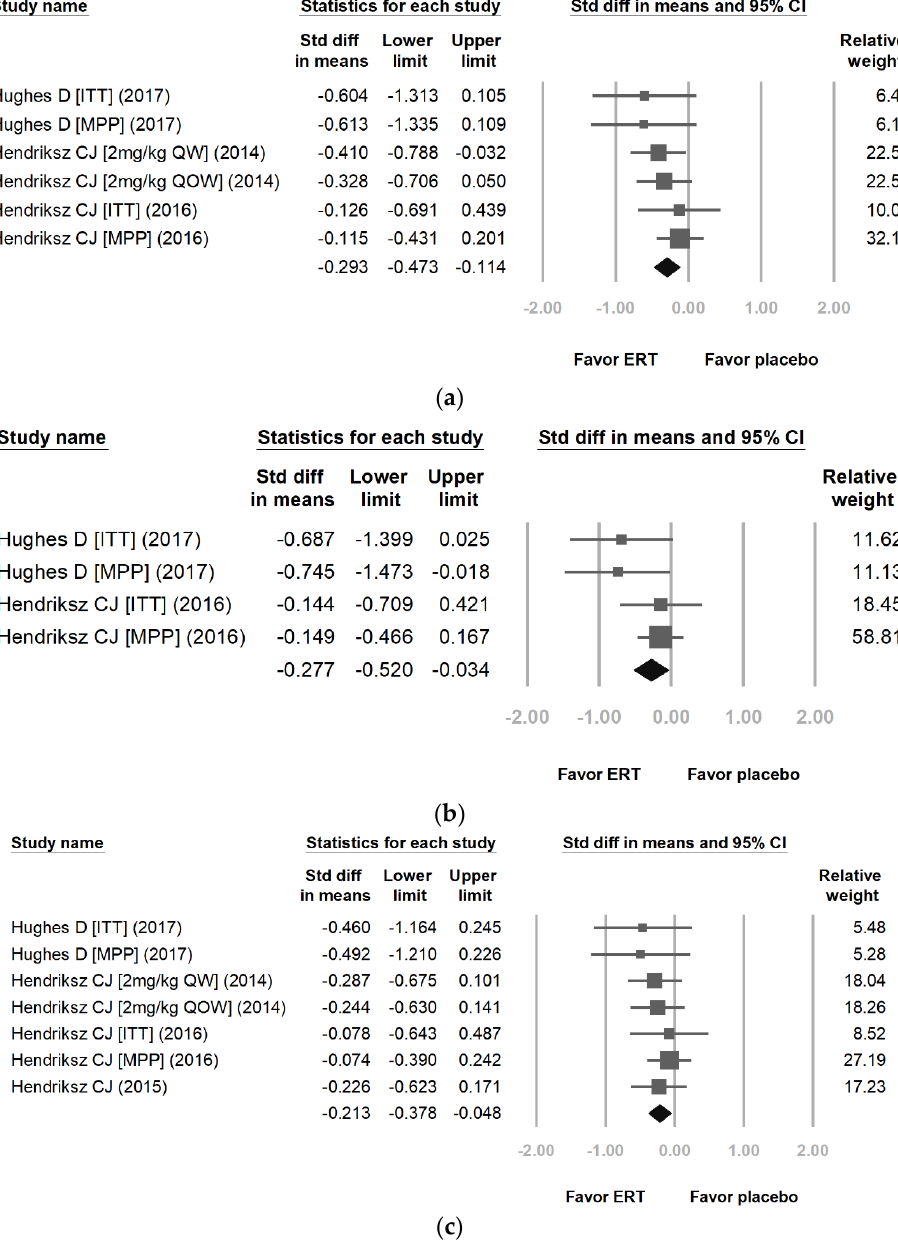
Figure 5. Proportional meta-analysis result for a pooled proportion from two cohort studies and one randomized controlled trial (RCT) for forced vital capacity (FVC), the first second of forced expiration (FEV1), and maximal voluntary ventilation (MVV) in MPS IVA. The pooled proportions analysis showed that the difference in means of ( a ) FVC [22,24,26], ( b ) FEV1 [22,24], and ( c ) MVV [22,24,26,27] between the enzyme replacement therapy (ERT) group and the placebo treatment group were ( a ) − 0.293 [95% CI: − 0.473, − 0.114; heterogeneity: I 2 = 0.00%, p = 0.631; overall effect: p = 0.001], ( b ) − 0.311 [95% CI: − 0.601, − 0.020; heterogeneity: I 2 = 18.90%, p = 0.296; overall effect: p = 0.025], and ( c ) − 0.213 [95% CI: − 0.378, − 0.048; heterogeneity: I 2 = 0.00%, p = 0.902; overall effect: p = 0.011] (ITT: intention to treat; MPP: modified per protocol). (Reprinted/adapted with permission from Ref. [22], 2017, Hughes et al.; Ref. [24], 2016, Hendriksz et al.; Ref. [26], 2014, Hendriksz et al. and Ref. [27], 2015, Hendriksz et